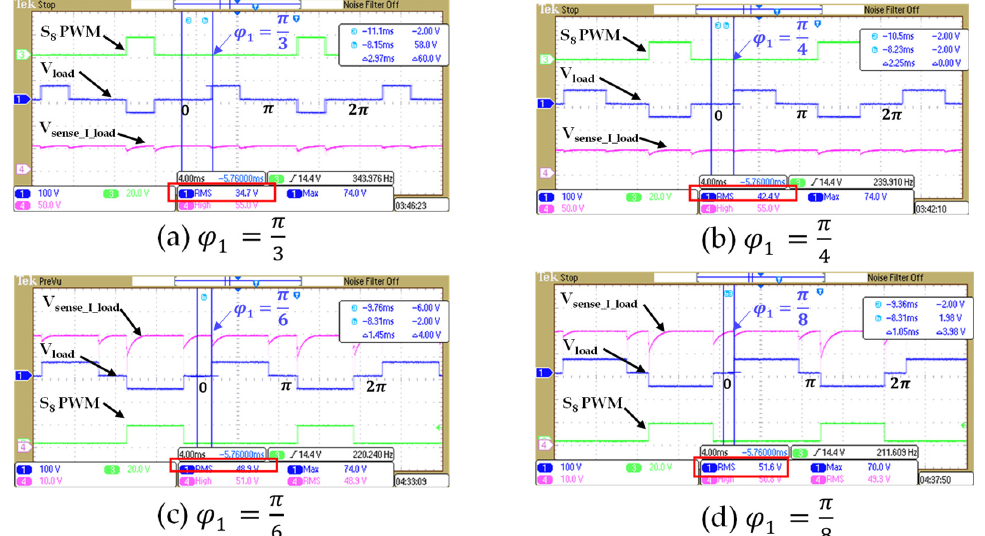
Figure 17. Experimental results—effect of increase in firing angles for 3-level inverter output .